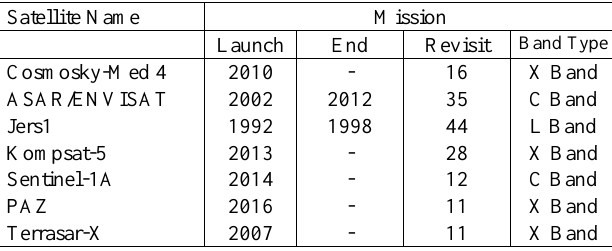
Table 1. Kinds of Radar Products and Missions